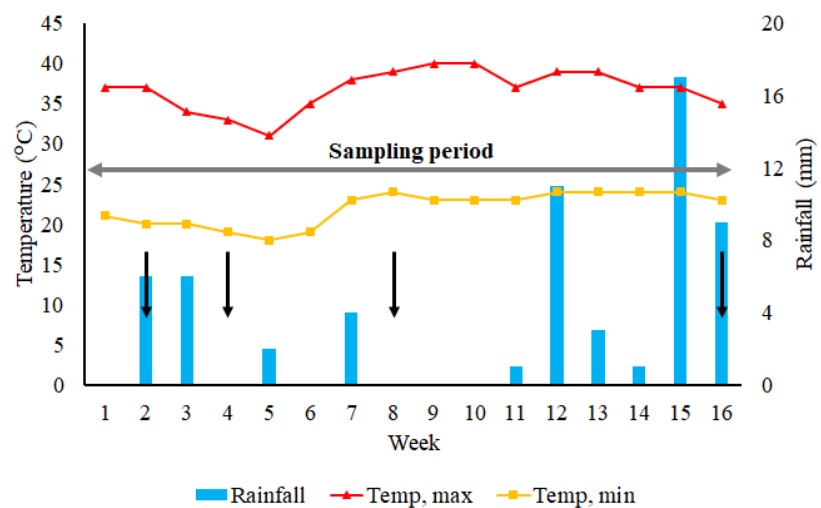
Figure 1. Weekly rainfall (mm) and mean weekly maximum and minimum temperature (°C) from March to June (dry period), i.e., till the start of the rainy season. The four sample dates are indicated by arrows.